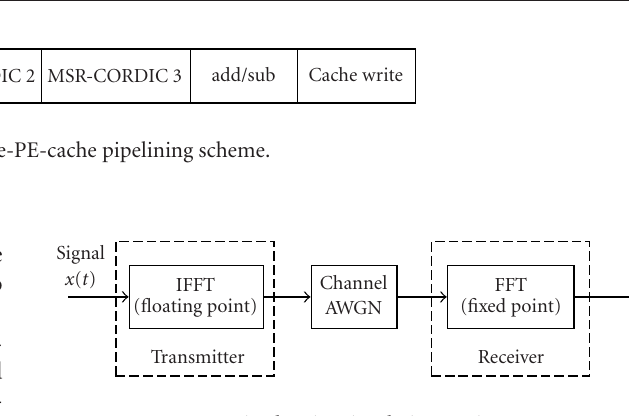
Figure 10: Fixed-point simulation environment.